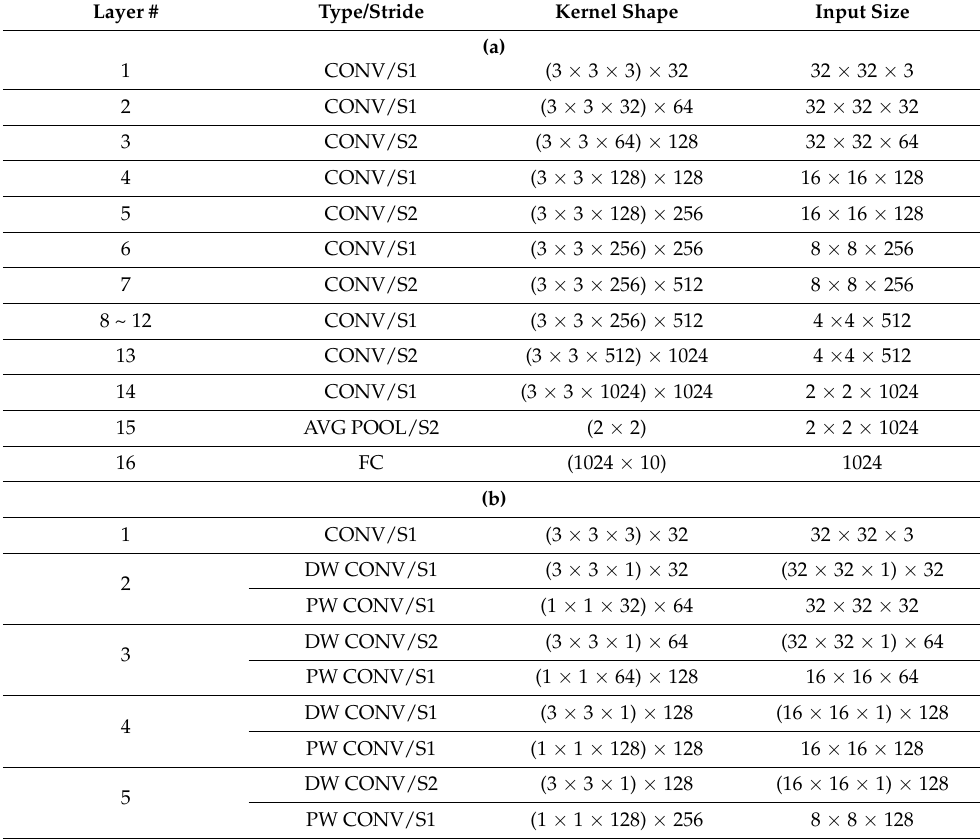
Table 1. (a) The neural network’s architecture of sub-image convolution using 3D kernels. (b) The neural network’s architecture of sub-image convolution using 2D and 1D